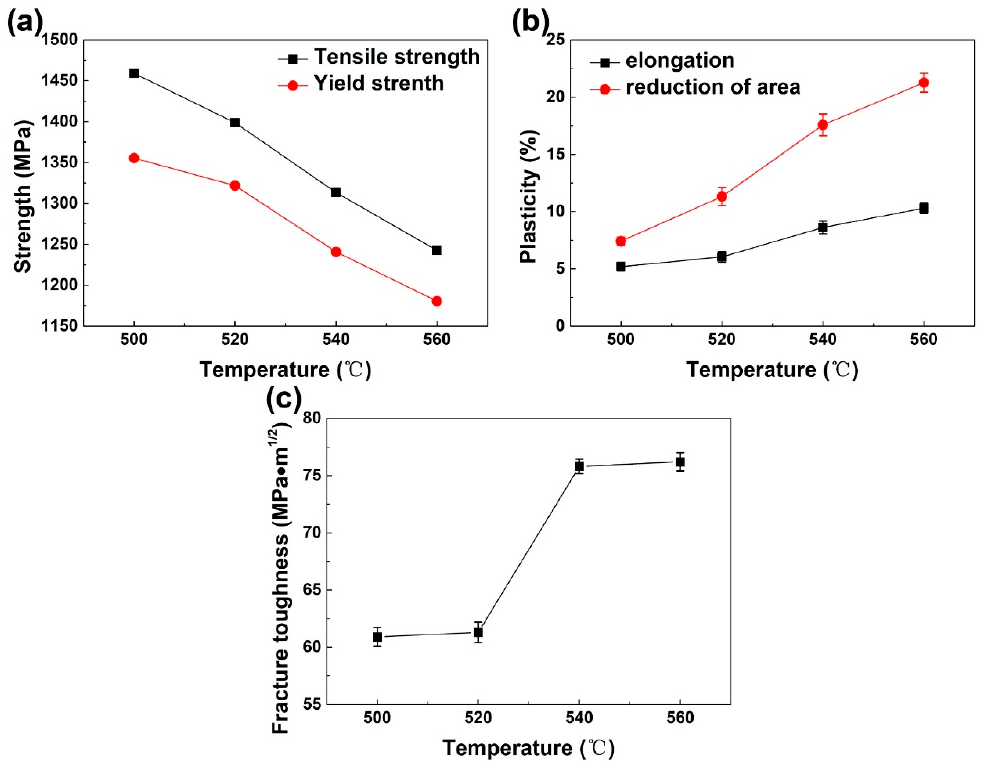
Figure 9. The variations of mechanical properties with aging temperatures: ( a ) strength, ( b ) plasticity, and ( c ) fracture toughness. Table 4. Mechanical properties of the alloy after aging for 8 h.